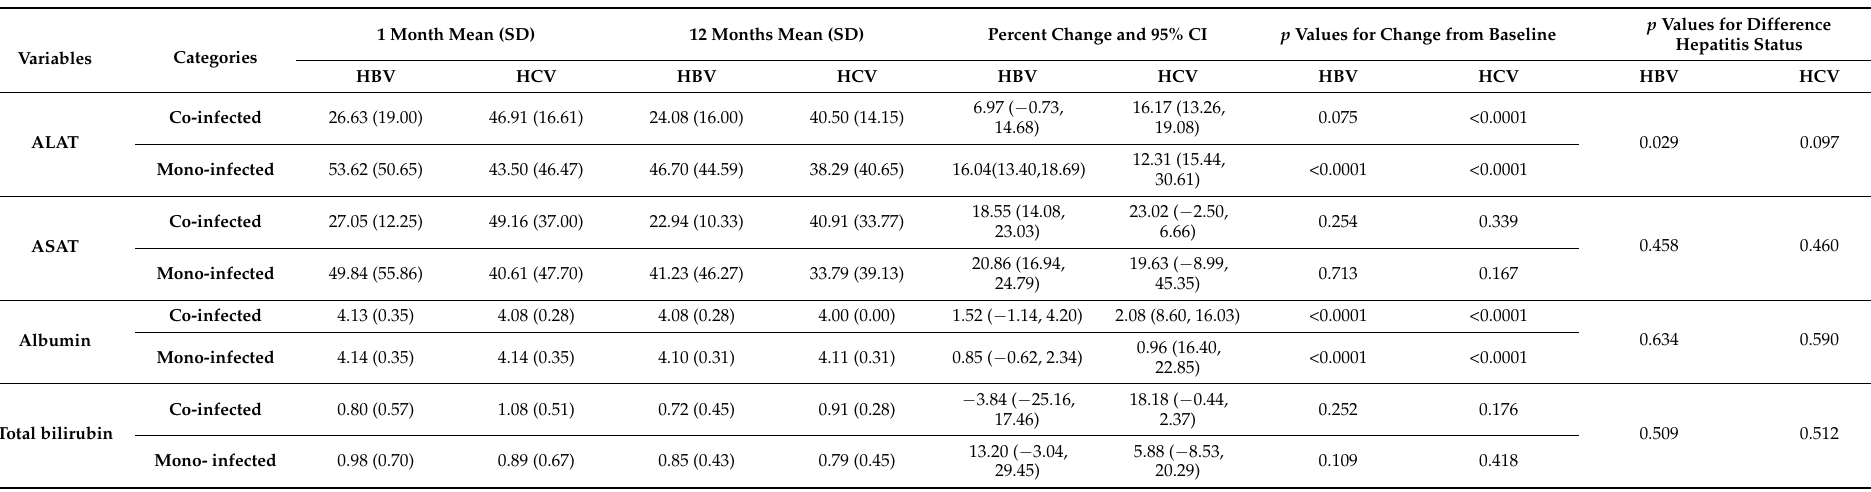
Table 8. Mean liver function measurements and percentage change between 1 and 12 months in HIV/HBV and HIV/HCV co-infected and HIV mono-infected patients.